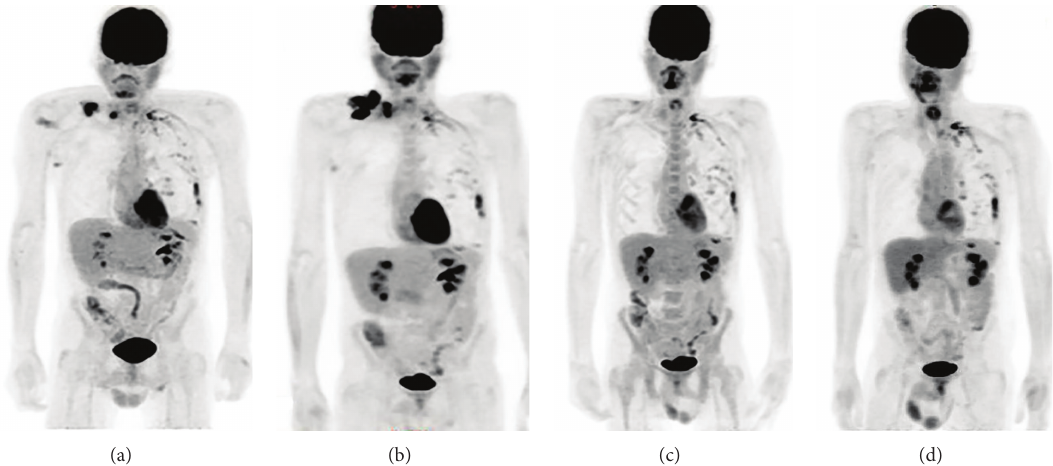
Figure 4: (a) PET scan during brentuximab therapy, (b) PET scan after 2 cycles of bendamustine, (c) PET scan after 2 cycles of GCD, and (d) PET scan at conclusion of treatment with GCD. Pleurodesis inflammatory changes remained on imaging.